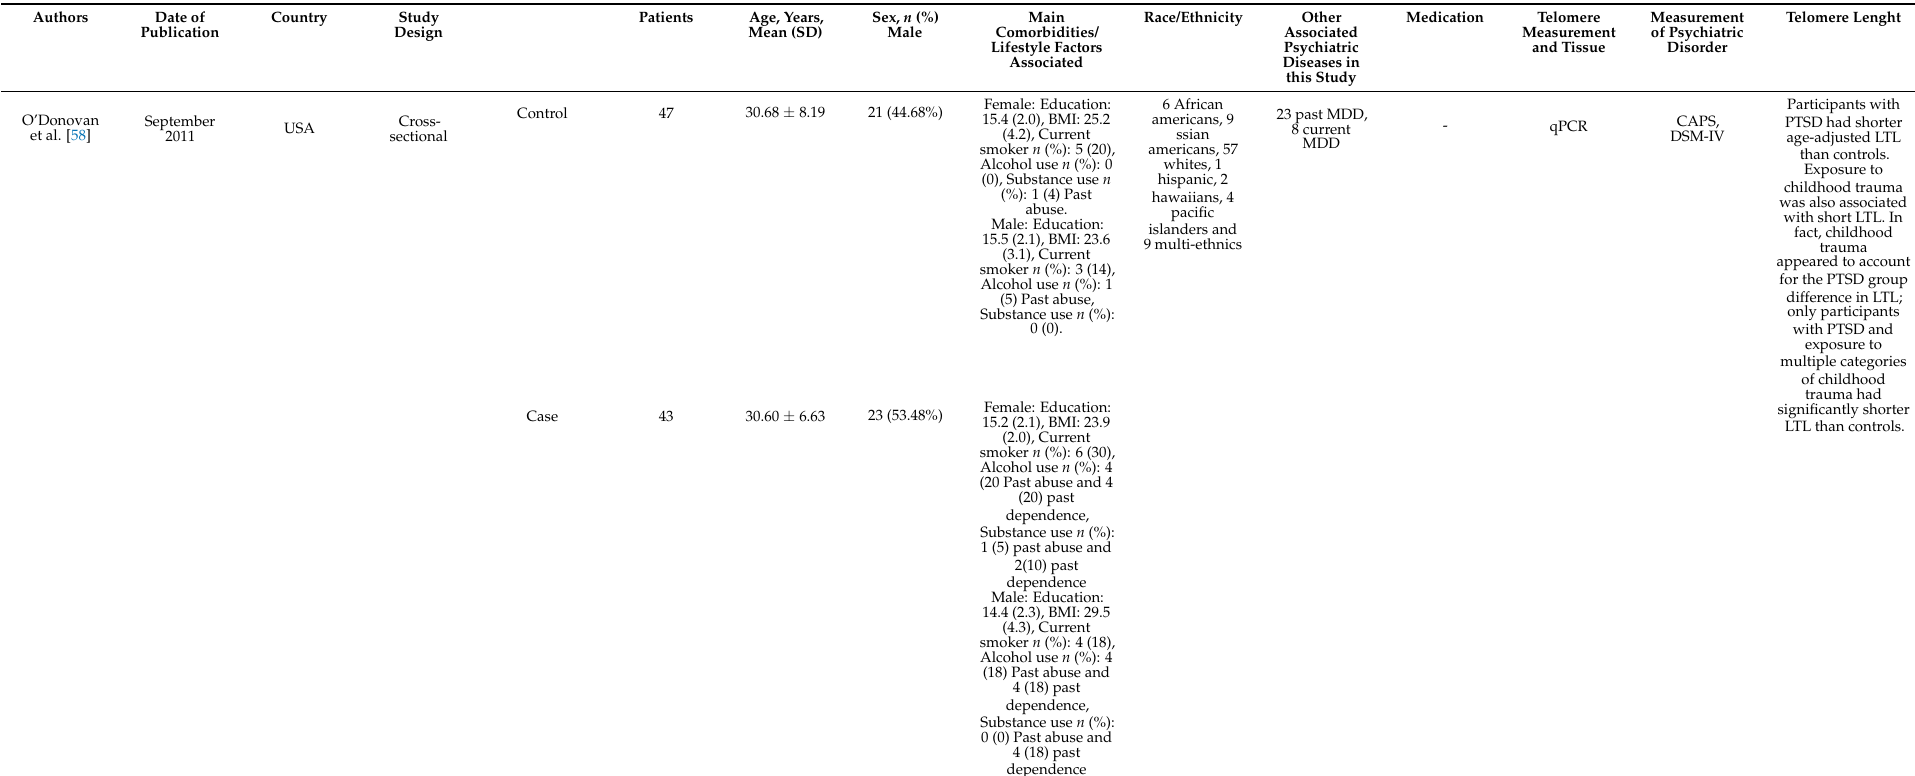
Race/Ethnicity Other